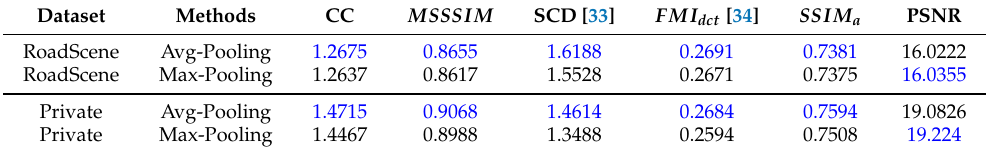
Table 5. The average values of quality metrics for 20 fused images on two datasets with different pooling methods. The best values are indicated in